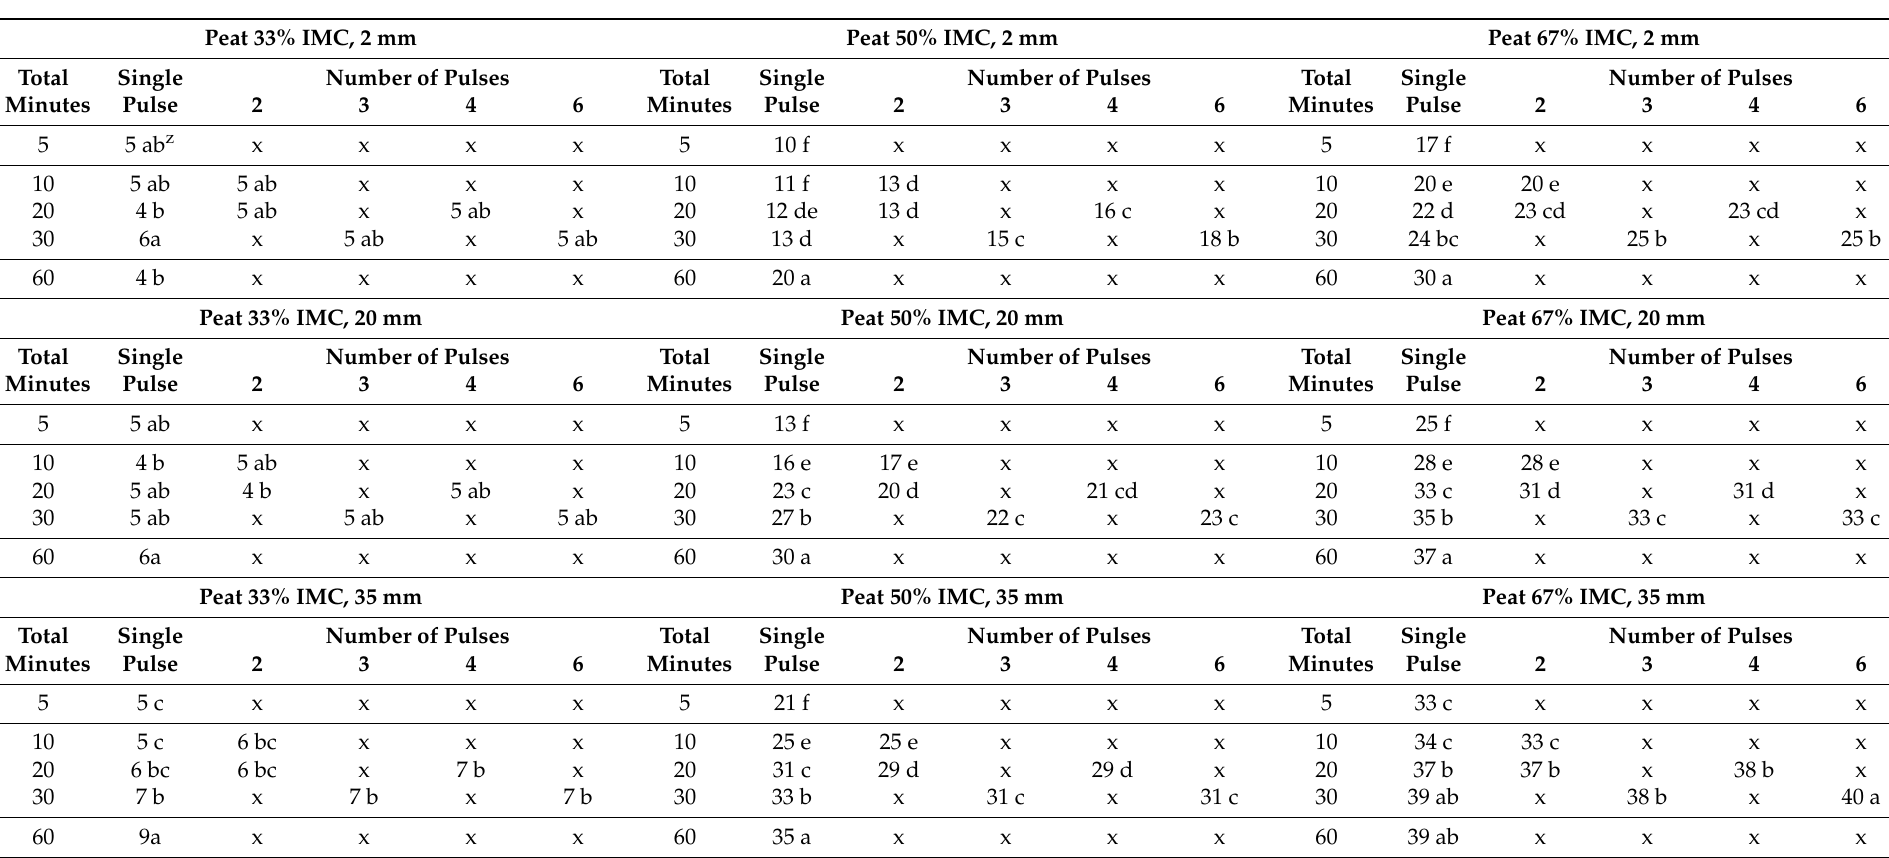
Table 3. Average water capture (% VWC) of peat at three initial moisture contents (IMC) of 33%, 50%, and 67%, three irrigation water levels of 2 mm, 20 mm, and 35 mm, and at five irrigation pulse durations (by event total) per water